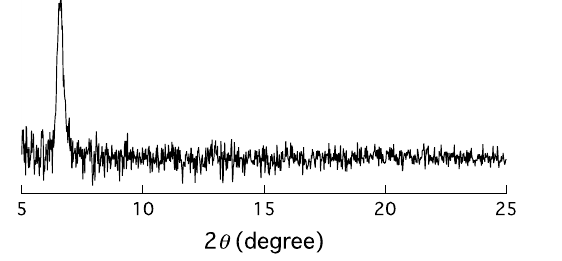
Figure 3. X-ray diffraction pattern of an F 8 CuPc film deposited on a SiO 2 /n-Si substrate.